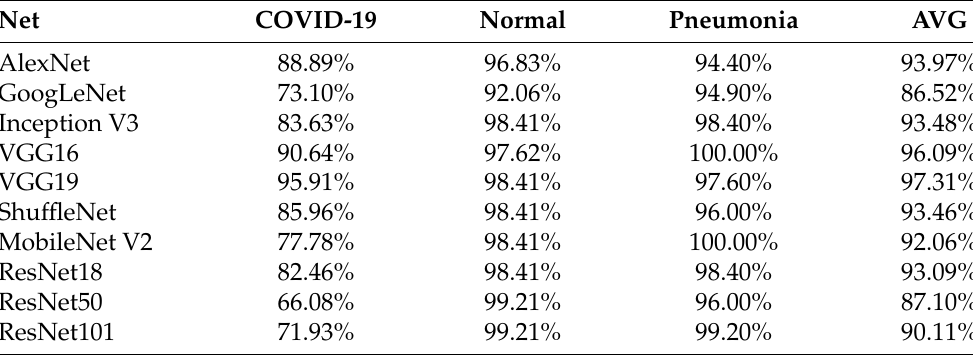
Figure 4. MAvG and classwise accuracy trends with the different classifiers adopted. Cov, Norm, Pne stands for the COVID-19, normal, and pneumonia classes, respectively. Table 3. Patient-oriented testing with COVIDx